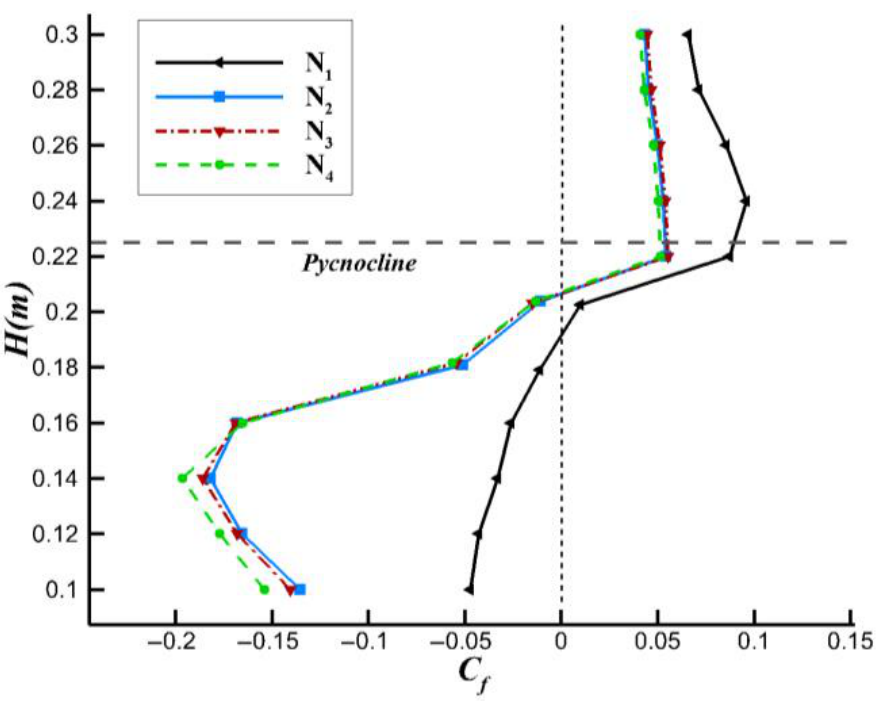
Figure 8. Comparison diagram of layered horizontal resultant force under four working conditions, C Fn = C Fn-max .